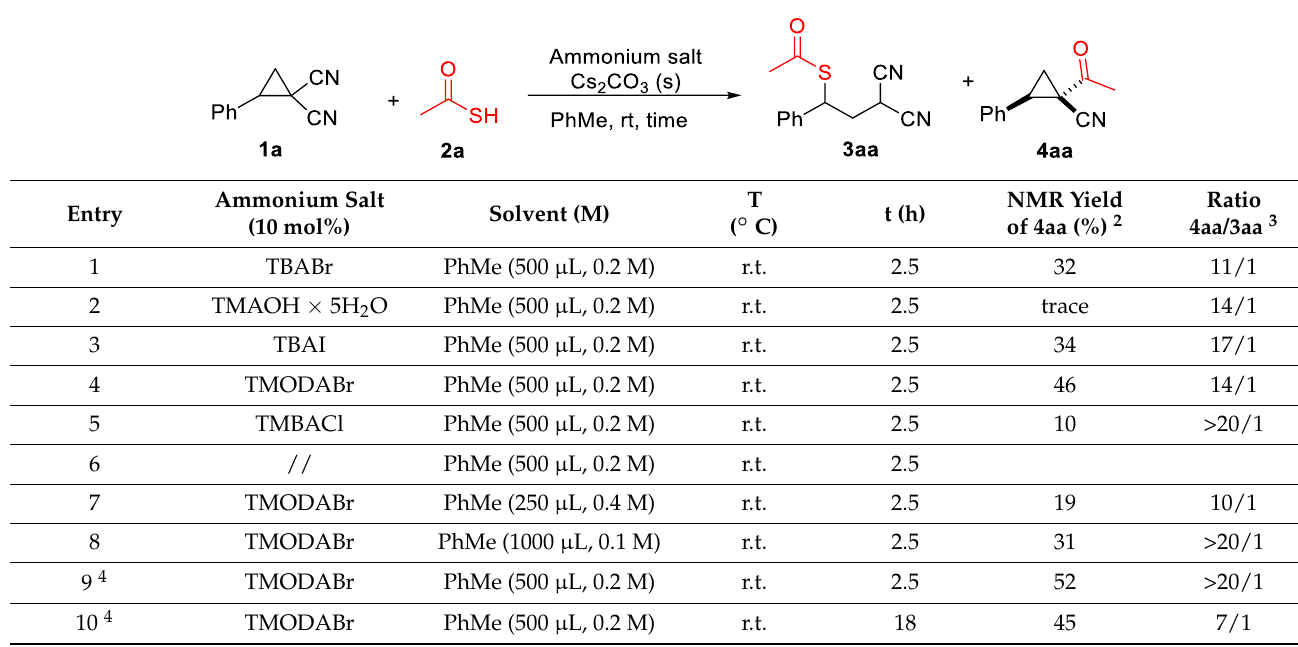
Table 1. Ammonium salt screening 1 .